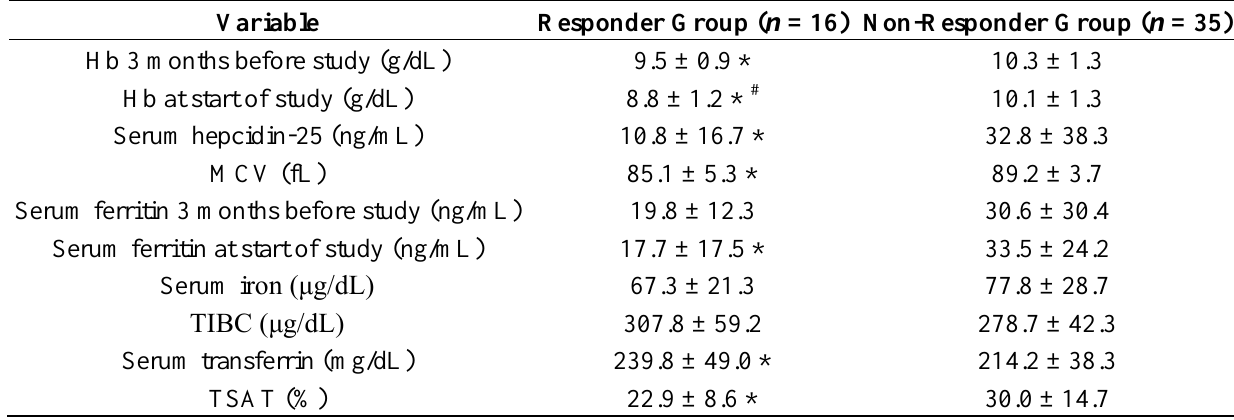
Table 2. Hb, serum hepcidin-25, MCV and iron-related parameters before the start of